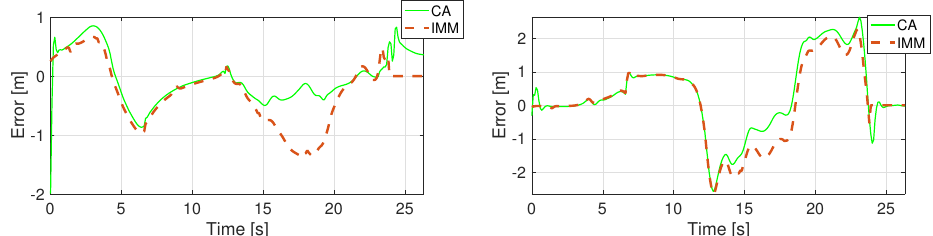
Figure 7. Position error in direction X ( left ) and Y ( right ) using the CA model.